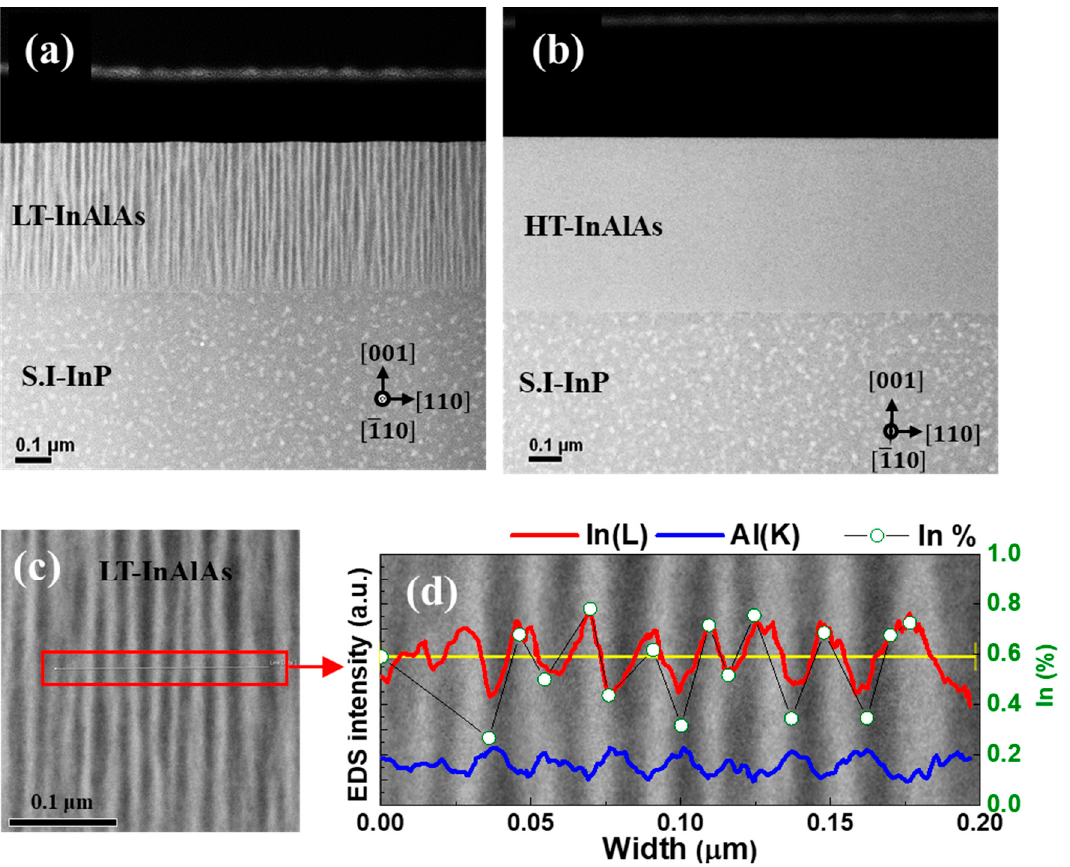
Figure 3. Cross-sectional STEM images for InAlAs grown at a temperature of ( a ) 500 °C and ( b ) 660 °C. ( d ) is an EDS line scan obtained from the dashed rectangle in ( c ), a magnified image of the InAlAs layer in ( a ). The red and blue lines indicate In(L) and Al(K) intensities measured from EDS, and green circles indicate corresponding In composition at specific points.